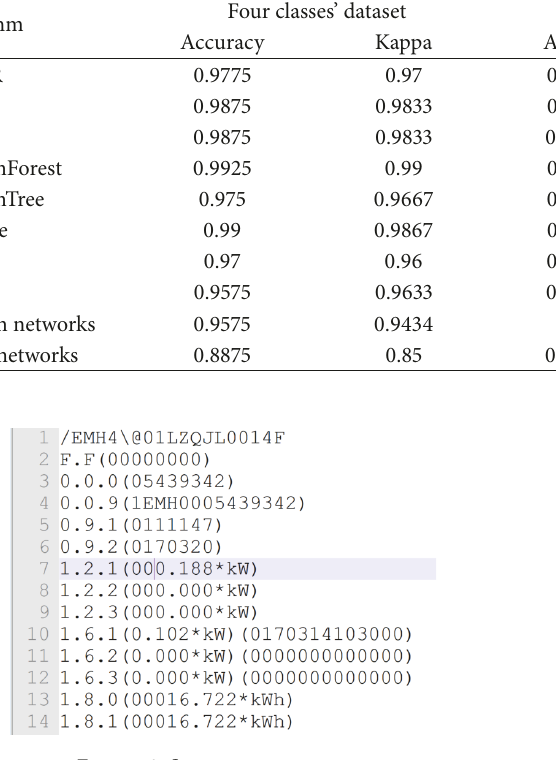
Figure 8: Smart-meter response.